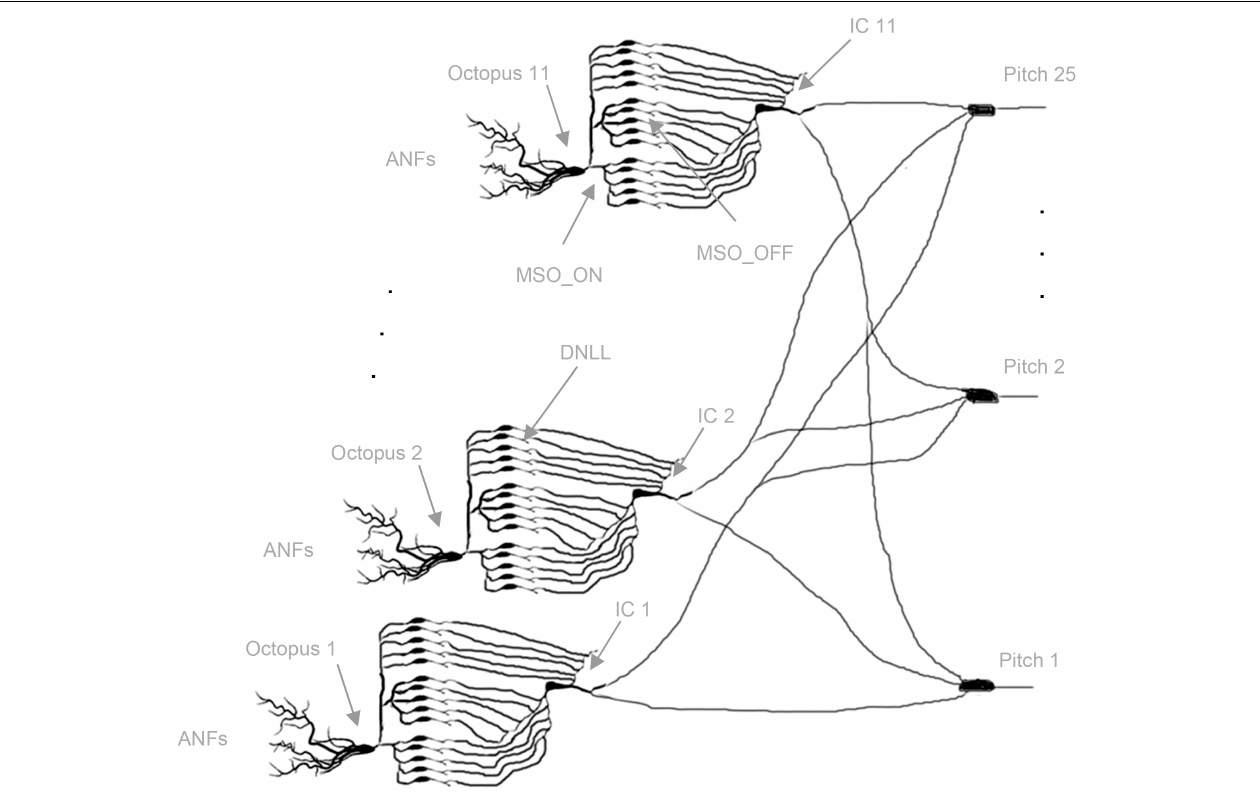
FIGURE 4 | Topology of the neural network. Starting from left, octopus cells receive input from ANFs in their temporal receptive fields (three out of 11 are shown); each dendritic end branch connects to an ANF (not shown). Octopus cells trifurcate to MSO_ON neurons (bottom blocks: five out of 100 shown), MSO_OFF neurons (middle blocks: five out of 100 shown), DNLL neurons (top blocks: five out of 200 shown); MSO_ON, MSO_OFF, and DNLL neurons connect to the bottom, middle, and top dendritic branches of the inferior colliculus (IC) neurons, respectively; IC neurons connect star-like to pitch neurons (three out of 25 are shown) (Cells redrawn from Siveke et al., 2006; Bal and Baydas, 2009; Wallace et al.,